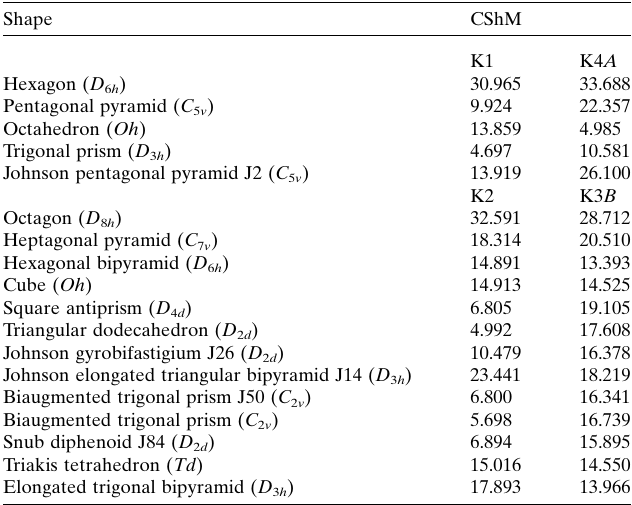
Table 2 Values for continuous shapes measures (CShM) of the polyhedra centred by the potassium cations (only major components for the disordered parts are considered). Shape